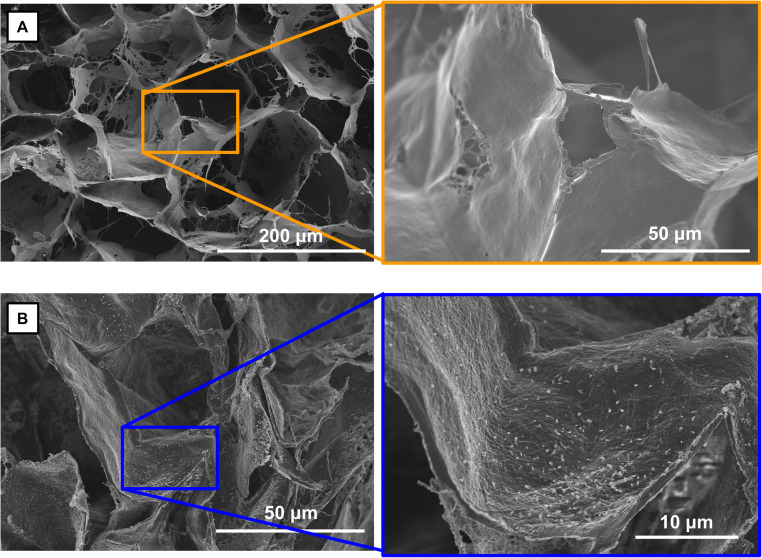
Visualization of PEI-pIL-1Ra nanoparticles in collagen-hydroxyapatite scaffold. (A) SEM image of the porous microarchitecture in CHA scaffolds, higher magnificent image shows smooth pore walls. (B) SEM image of a CHA scaffold activated with PEI-pIL-1Ra nanoparticles showing nanoparticles adhered to the porous structure.